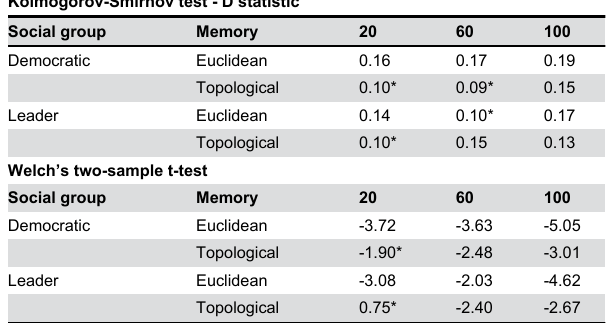
Table 3. Comparisons of daily step tortuosity between simulated and observed primate groups (mean observed group tortuosity = -1.7); ‘*’ indicates no significant difference at the p=0.05